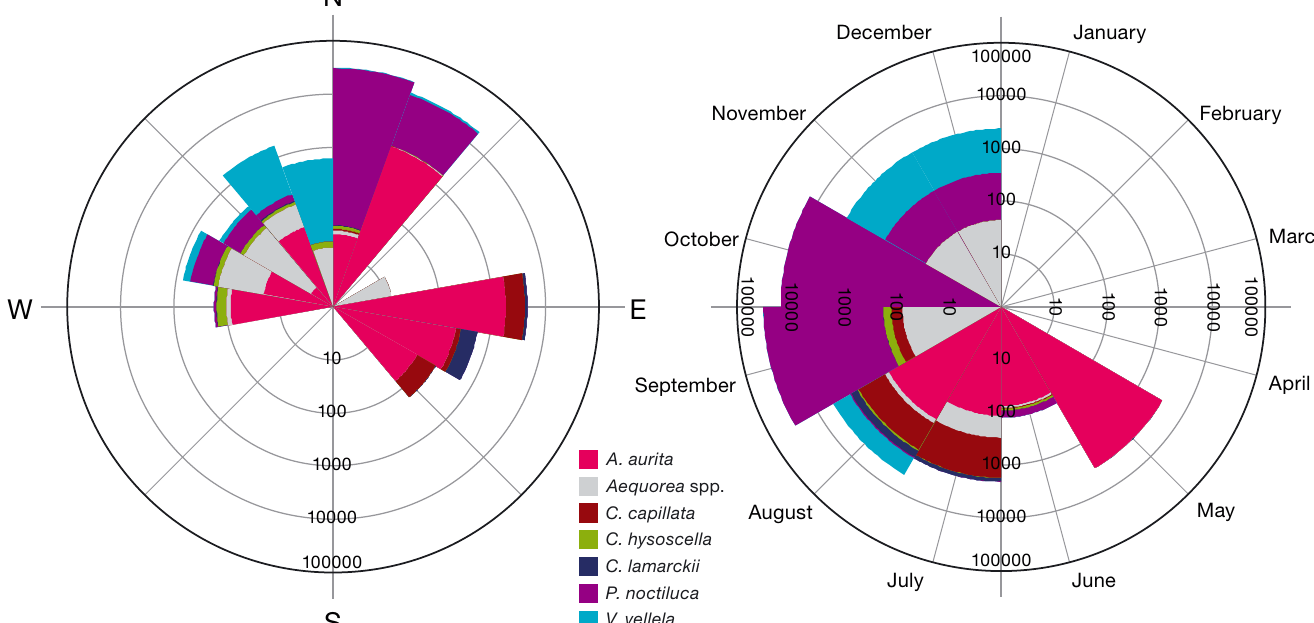
Fig. 3. Relative proportions of all jellyfish species by location around the coast of the north of Ireland in each month. The cir- cular axis represents location (left) and month (right), and position on the grid (stacked wedge) indicates relative proportions of all stranded jellyfish. In particular, these plots highlight the ubiquity of Aurelia aurita and the predominance of Cyanea capillata and Pelagia noctiluca at locations proximate to the Irish Sea and Atlantic, respectively. Note the use of log 10 scales.